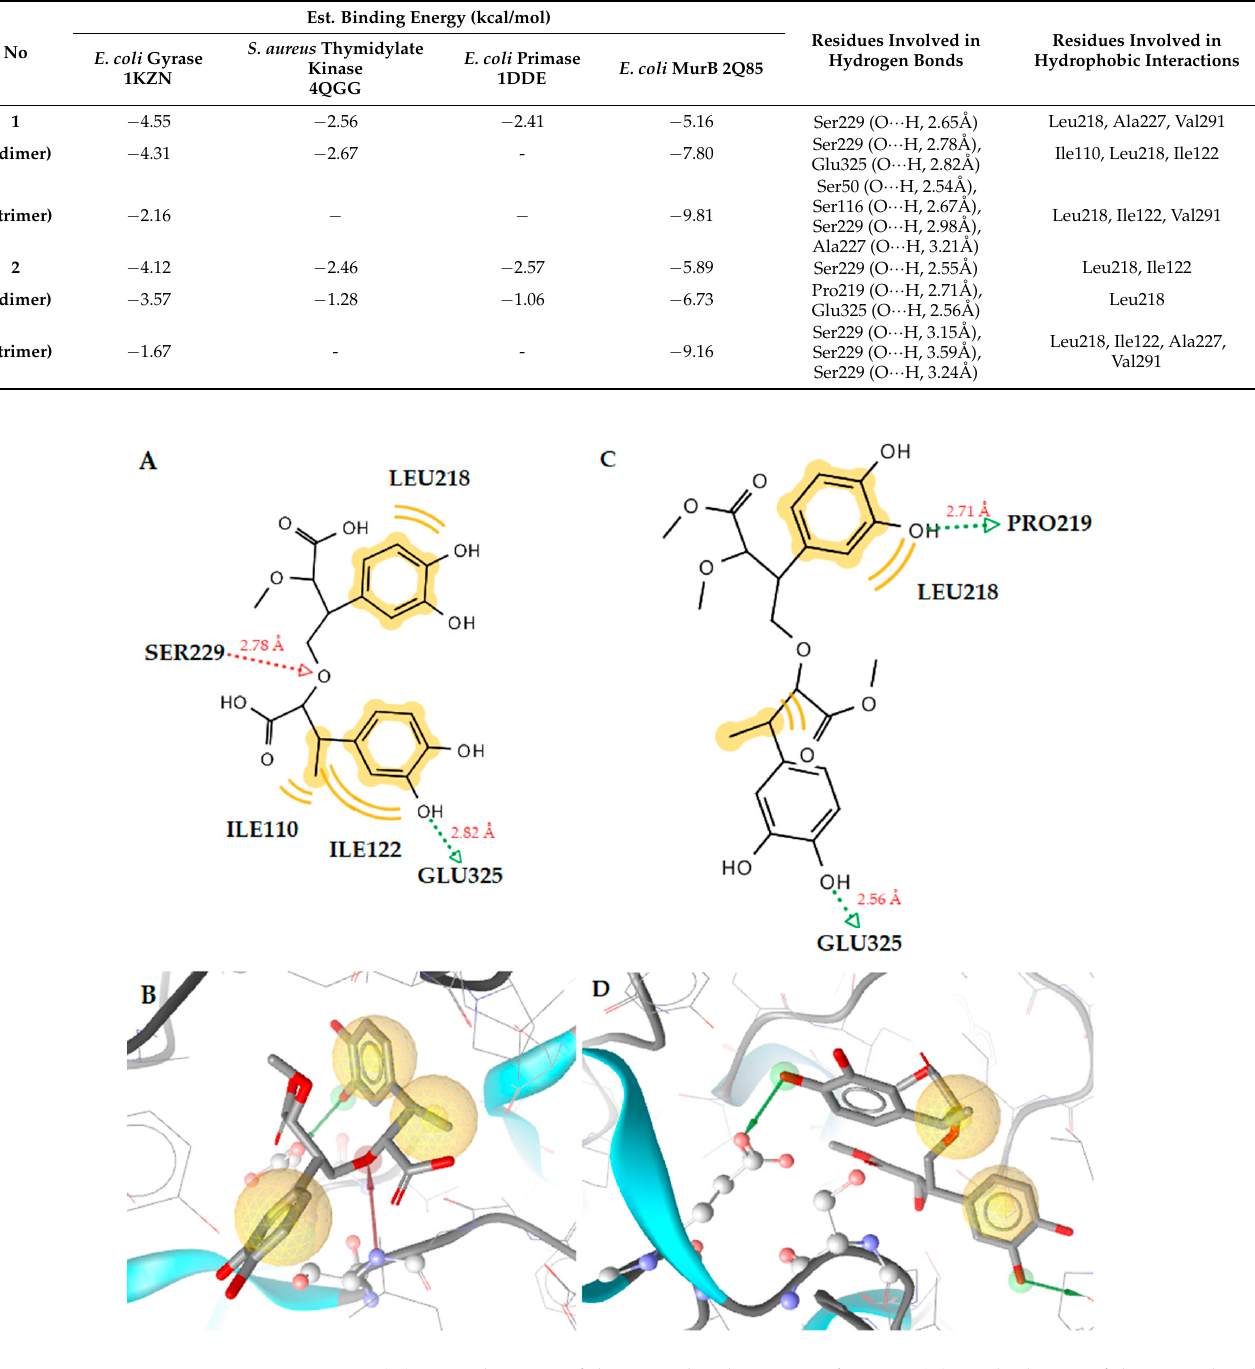
Figure 4. ( A ) Docked pose of trimer molecule 1 in E. coli MurB. ( B ) A 2D diagram of trimer molecule 1 in E. coli MurB. ( C ) Docked pose of trimer molecule 2 in E. coli MurB. ( D ) A 2D diagram of trimer molecule 2 in E. coli MurB. Red and green dotted lines show the hydrogen bonds. Yellow spheres represent hydrophobic interactions. Hydrogen bond interactions with the residue Ser229 were also observed for the trimers of both compounds.